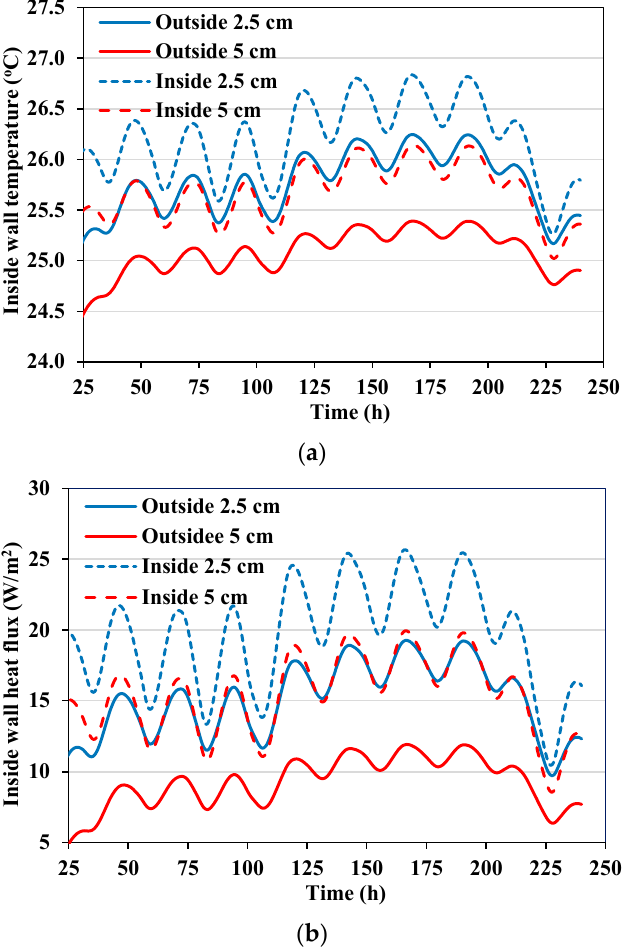
Figure 8. Effect of the insulation thickness and location on the thermal bridge of the intermediate floors using EIFS wall type. ( a ) inside wall temperature, ( b ) inside heat flux.